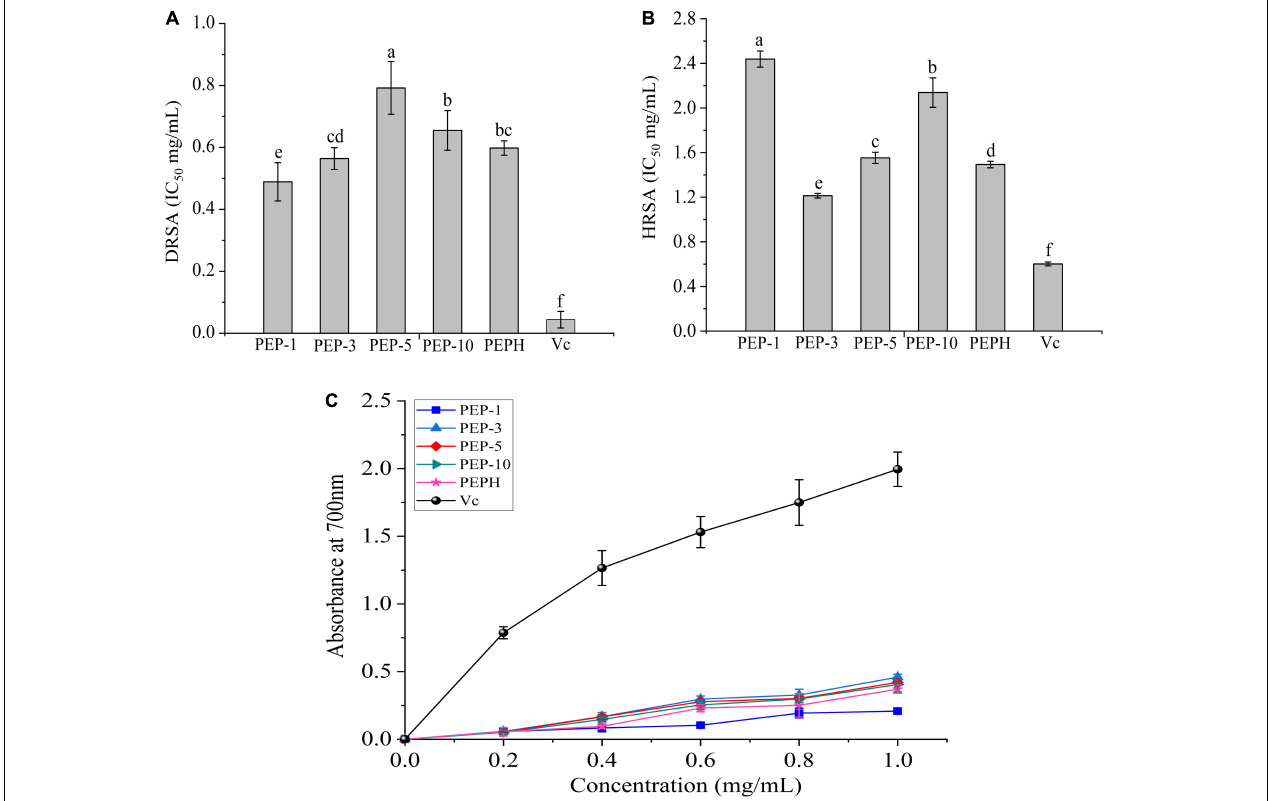
FIGURE 1 | Antioxidant activities in vitro . (A) DPPH radical scavenging activity expressed as IC 50 , (B) hydroxyl radical scavenging activity expressed as IC 50 , and (C) reducing power with Vc as the positive control. PEP-1: P. eryngii polypeptides with a molecular weight of < 1 kDa; PEP-3: P. eryngii polypeptides with a molecular weight of 1–3 kDa; PEP-5: P. eryngii polypeptides with a molecular weight of 3–5 kDa; PEP-10: P. eryngii polypeptides with a molecular weight of 5–10 kDa; PEPH: PEPH: P. eryngii protein hydrolysate; Vc: vitamin C (ascorbic